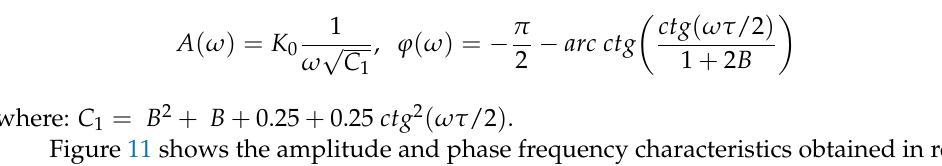
1 o of the control